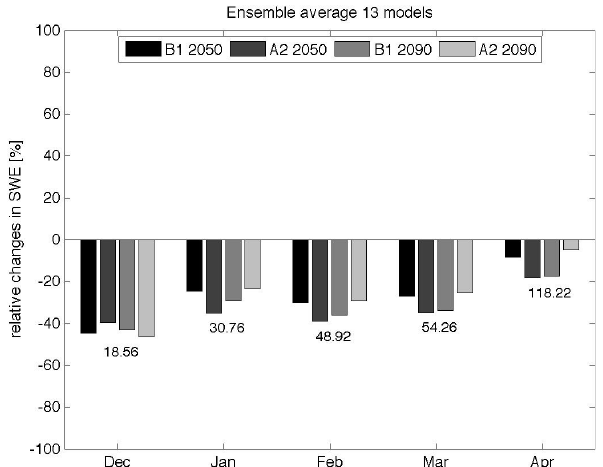
Fig. 11. Changes in modeled SWE across elevation zones for four scenario/time combinations. Each marker plot represents the aver- age VIC SWE outcome from the 13 GCM climate forcing